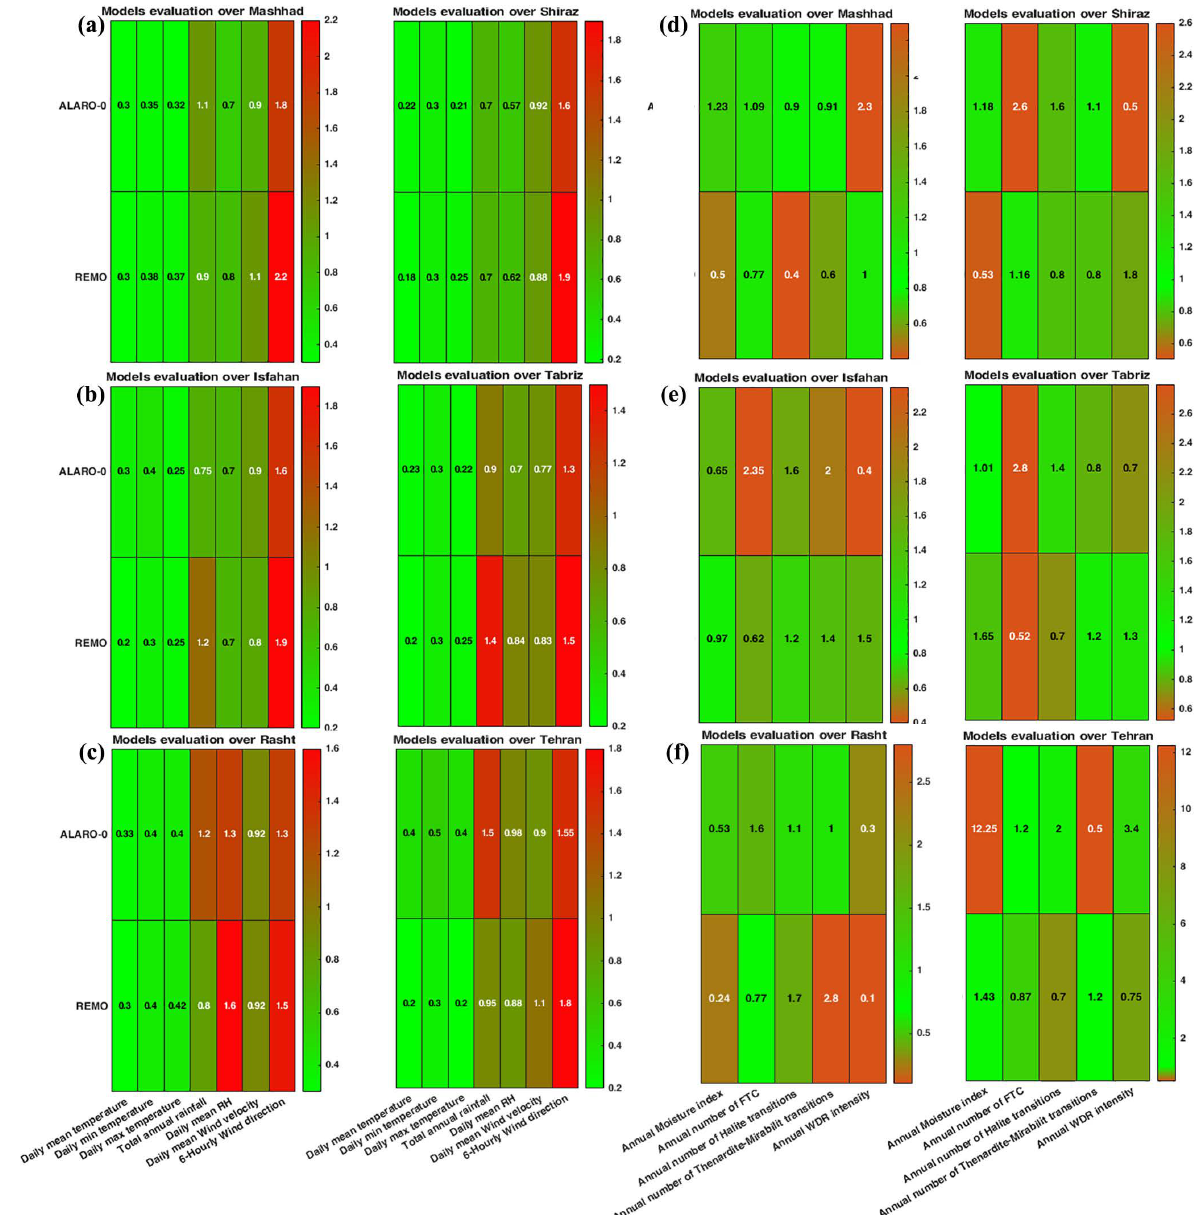
Figure 19. ( a – c ) Computed RMSD of models used for evaluating typical climatic parameters and ( d – f ) the normalised average values used for derived parameters over the studied stations: ( a , d ) Mashhad and Shiraz, ( b , e ) Isfahan and Tabriz and ( c , f ) Rasht and